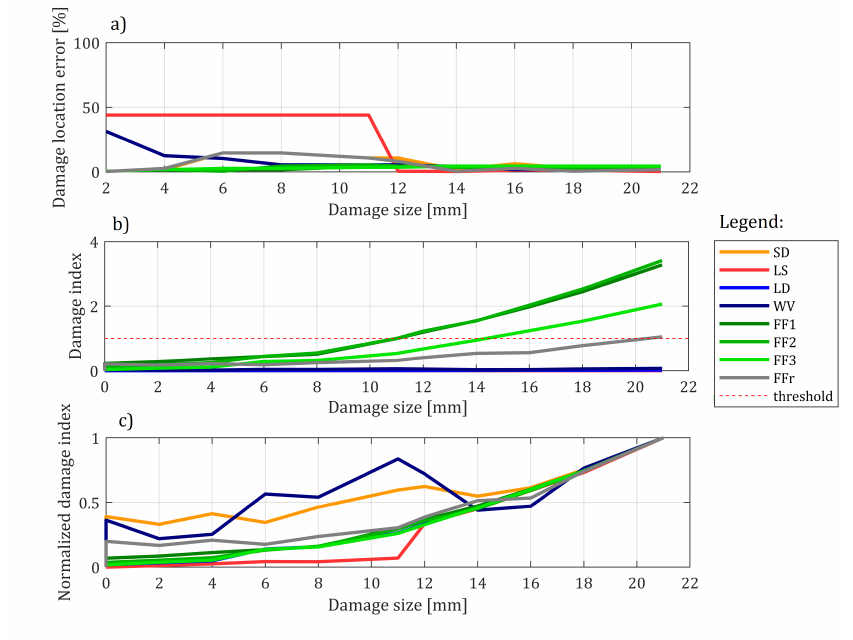
Figure 17. The results obtained for testing the 8 damage detection methods for one particular setup of the experiment (C#3): ( a ) Relative damage location error; ( b ) damage indication and ( c ) damage indication normalized with respect to the maximum for the given